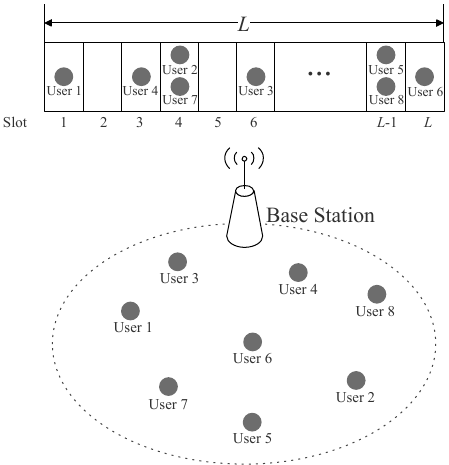
Figure 1. Each user randomly chooses a slot in the frame of length L when the number of active users ( N ) = 8